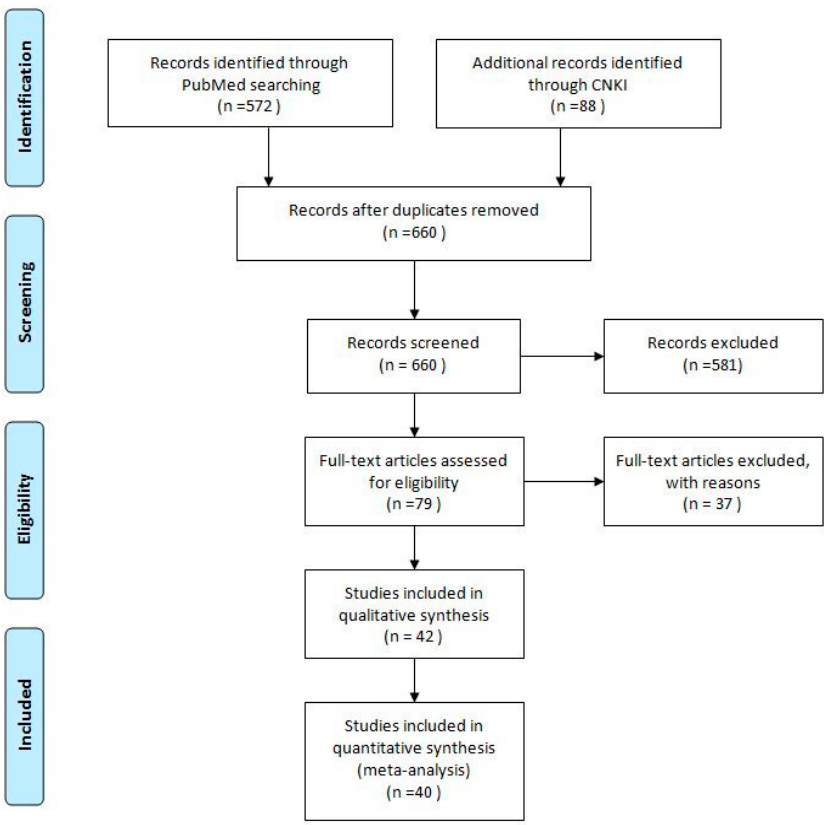
Figure 1. Flow chart of the literature search.